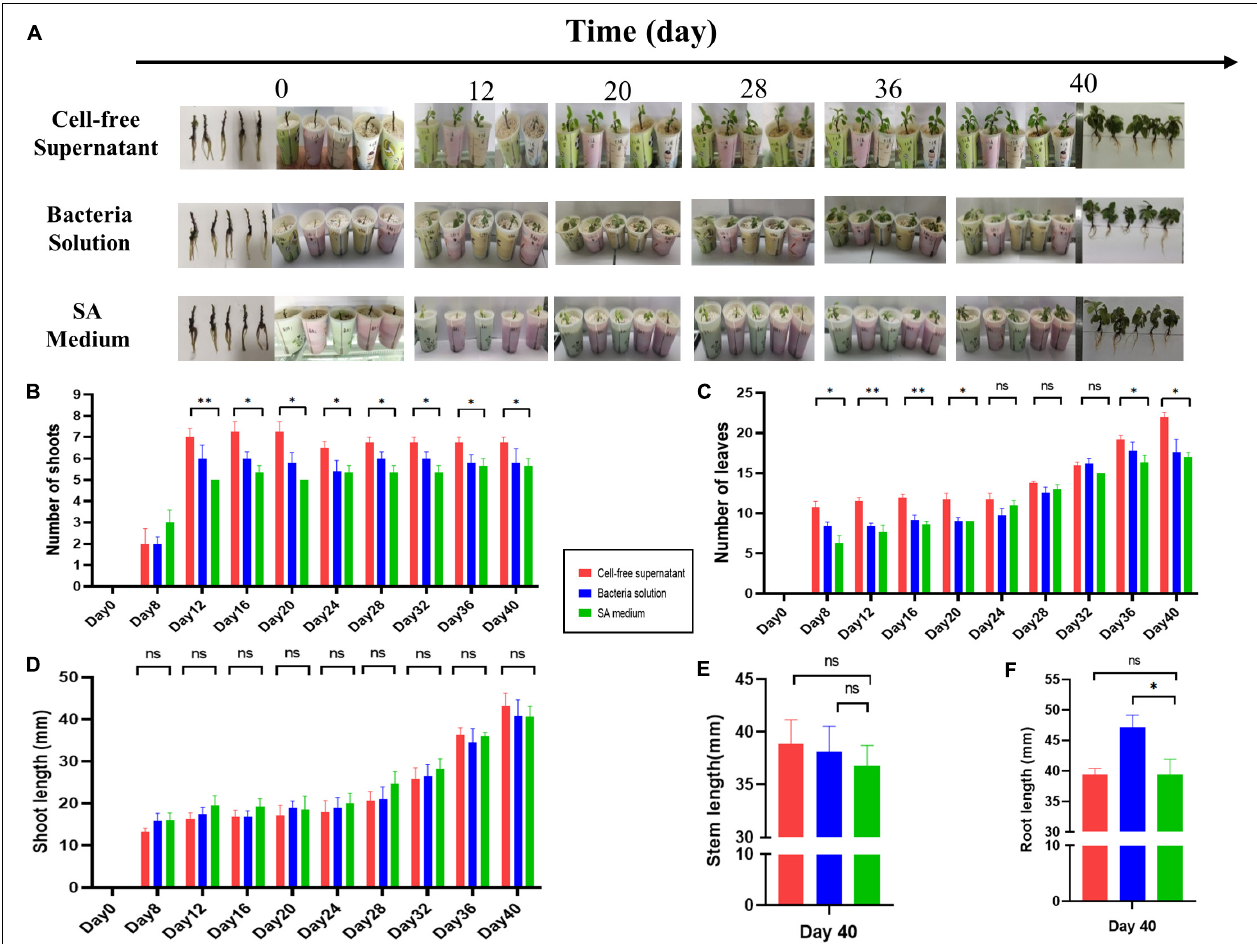
FIGURE 7 | Plant growth promoting effects of AS19. (A) Evaluation of the growth parameters of Gynura divaricata ( Linn. ) treated with CFS and bacterial solution of AS19. The SA medium group was the control group. (B) Number of shoots. (C) Number of leaves. (D) Shoot length. (E) Stem length. (F) Root length (ns, no significant difference, ∗ p < 0.05, ∗∗ p <